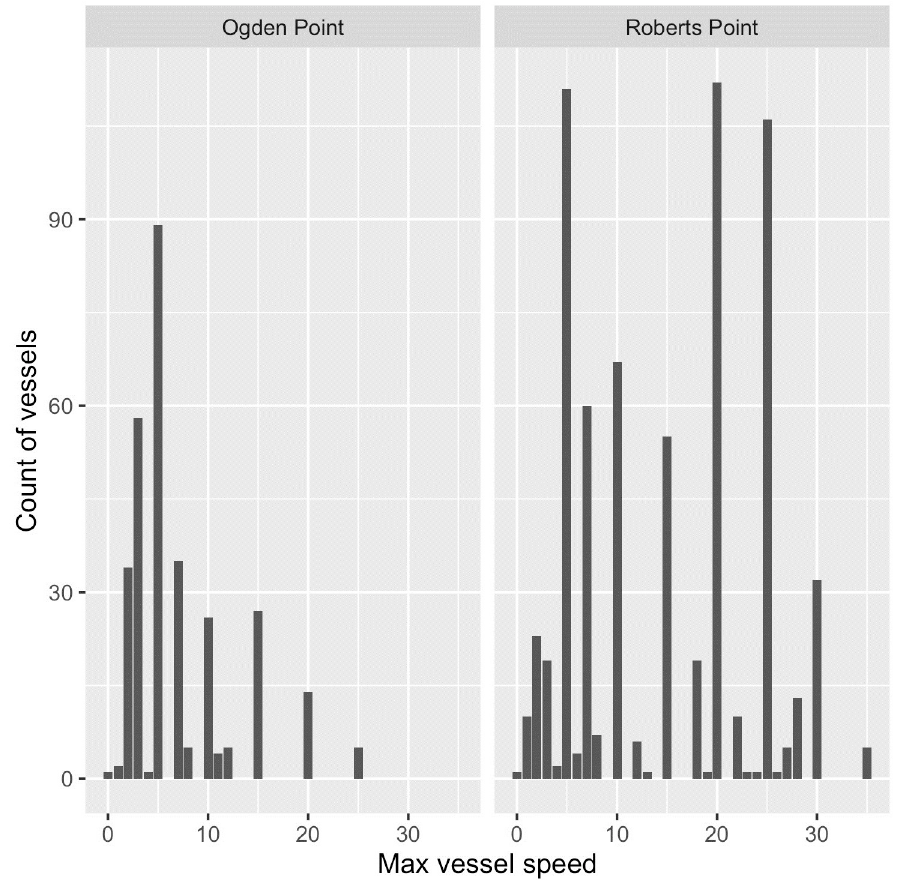
Fig 4. Frequency distribution of estimated maximum vessel speeds, Ogden Point (VHMBS) and Roberts Point (SHMBS), Greater Victoria, Canada.